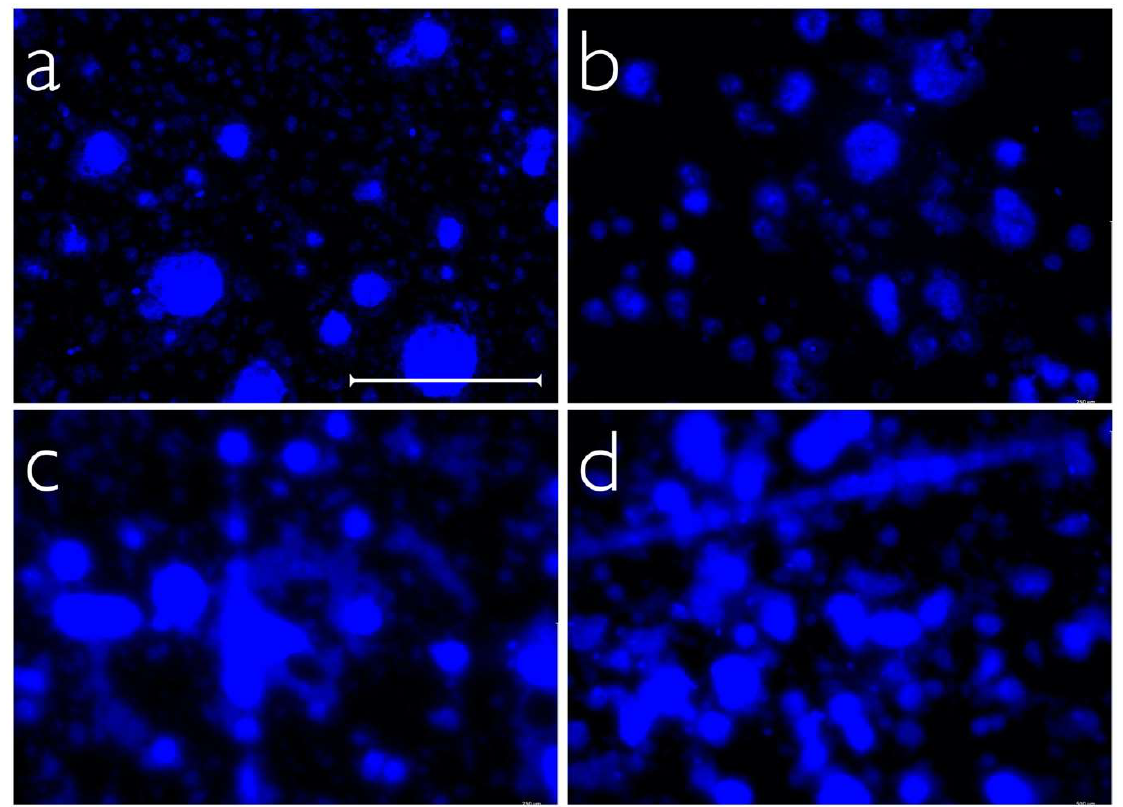
Figure 3. Exemplary fluorescence micrographs of titanium ( a ), zirconia ( b ), PEEK-BioHPP ( c ), and PEEK-VestaKeep DC4430R ( d ) after 24 h of in vivo biofilm formation and fluorescence staining (Hoechst 33342), scale bar equals 250 µm.